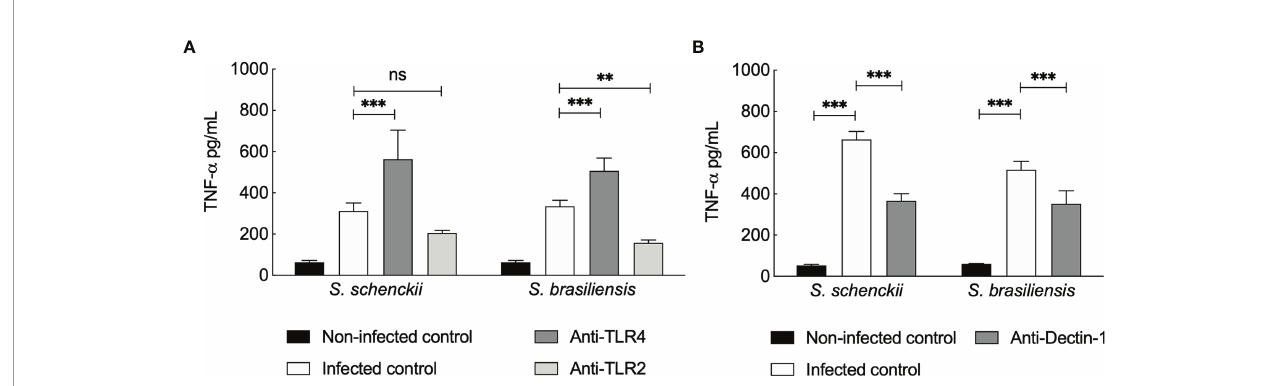
FIGURE 6 | Tumor necrosis factor (TNF)- a secreted by Sporothrix species infected human monocyte-derived macrophages (hMDMs) blocked for Toll-like receptor (TLR)4 and TLR2 (A) and Dectin-1 (B) . TLRs and Dectin-1 on hMDMs were blocked by preincubation (1 h) with TLR2-, TLR4-, or Dectin-1-speci fi c monoclonal antibodies, followed by interaction with S. schenckii or S. brasiliensis yeasts, in medium containing whole human serum (wHS). Non-infected controls were preincubated with medium containing wHS, and infected controls were incubated with Sporothrix species. Results are the mean ± SEM of at least two independent experiments performed in at least triplicate (n = 3 or more). Statistical analysis was performed by two-way ANOVA with Tukey ’ s multiple comparison posttest (ns = not signi fi cant; ****p < 0.0001, ***p < 0.001, and **p <